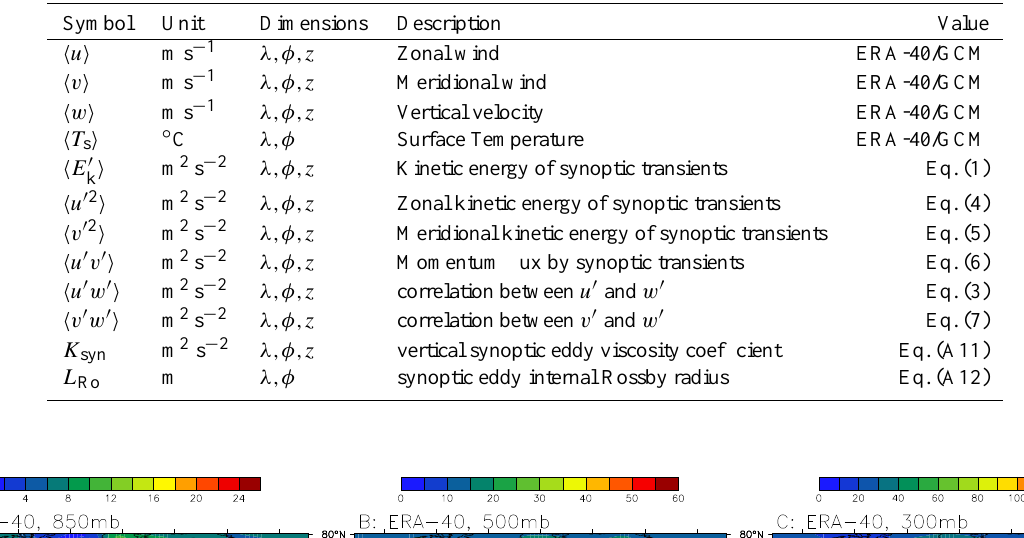
Table 1. Description of used variables.